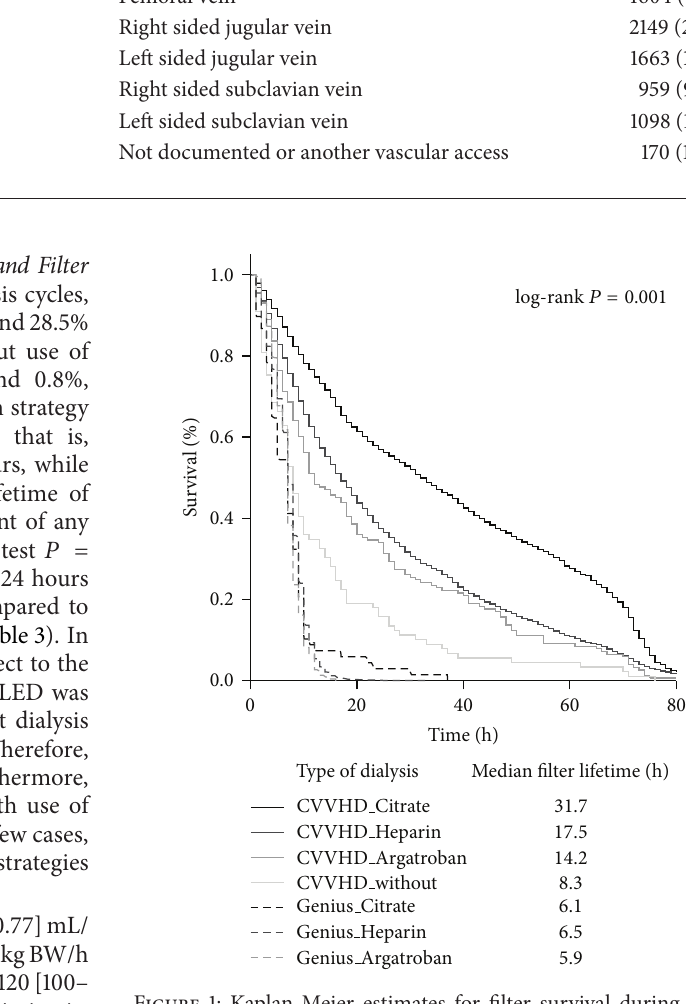
Figure 1: Kaplan-Meier estimates for filter survival during renal replacement therapy dependent on dialysis mode and anticoagula- tion